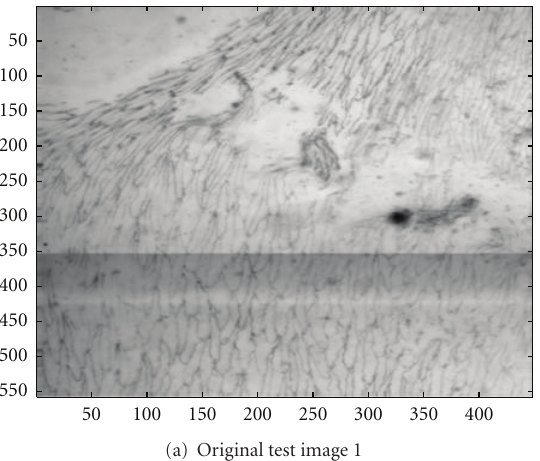
where TP, FP, TN, and FN are true positive, false positive, true negative, and false negative,